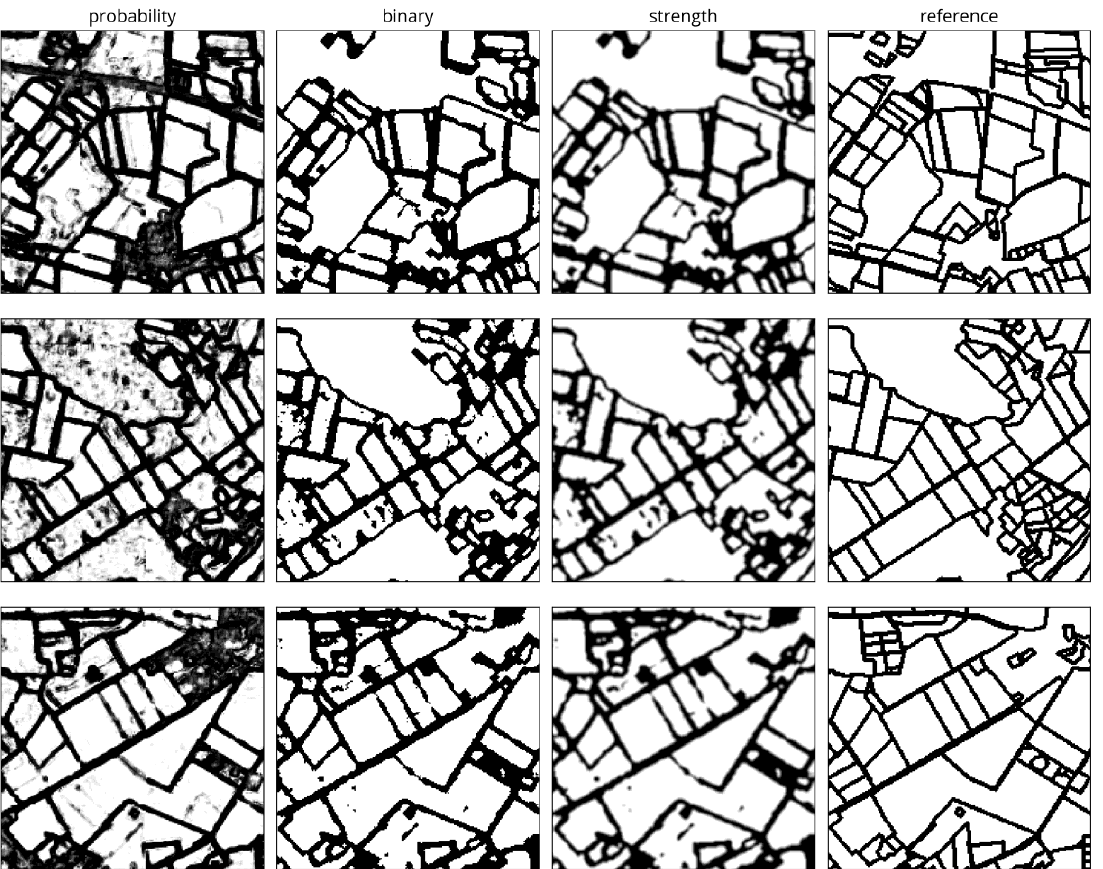
Figure 6. Comparison of boundary detection results in study area 2. Columns represent the model probability output, the binary output after land cover masking, the final boundary strength map, and the final reference dataset (boundaries thickened for visualization). Rows represent different subsets.